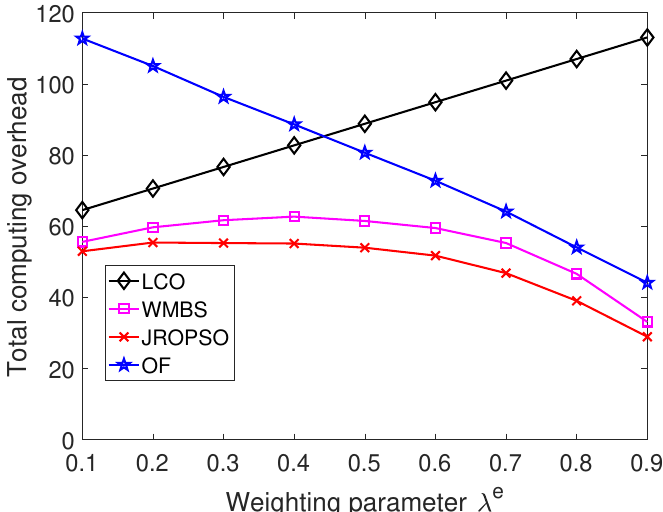
Figure 5. Performance evaluation under different weighting